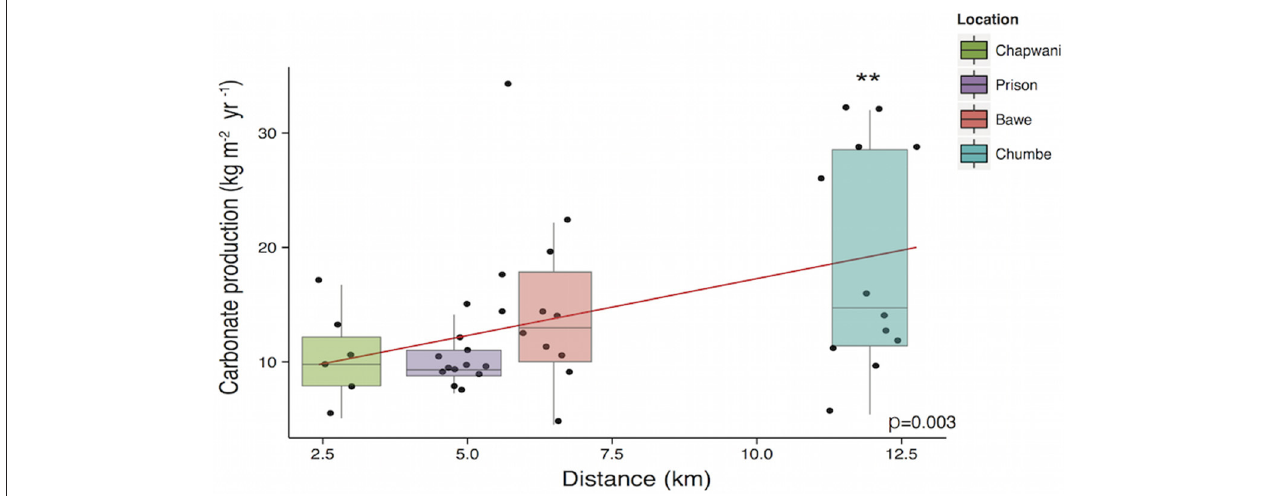
FIGURE 6 | Boxplot showing the gross calcium carbonate production per reef at 5 and 10m. The linear regression model shows the correlation between the calcium carbonate production and distance to Stone Town. ** p -values < 0.05.